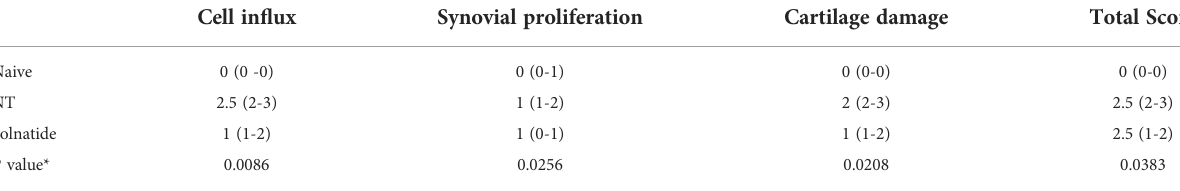
TABLE 1 Histopathological analysis of the effect of solnatide in mBSA